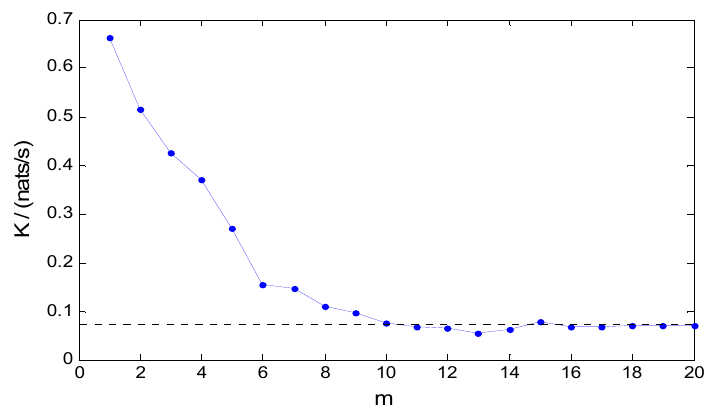
Figure 8. The curves of m ‐ K for BOD dataset.